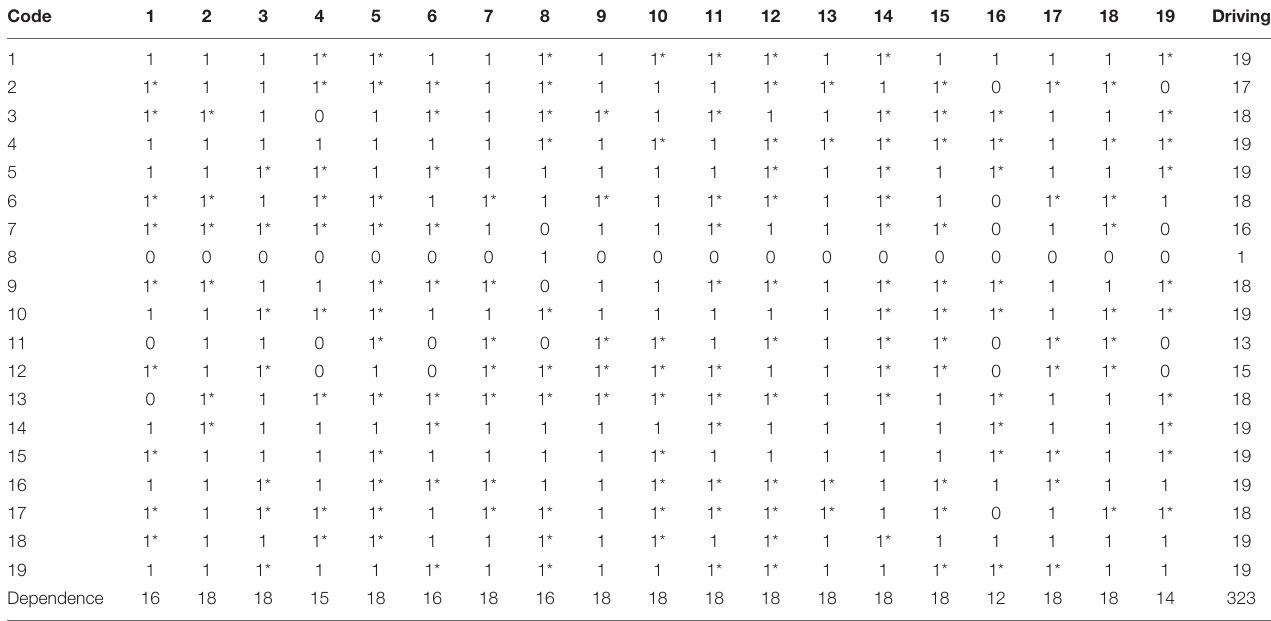
TABLE 4 | Final reachability